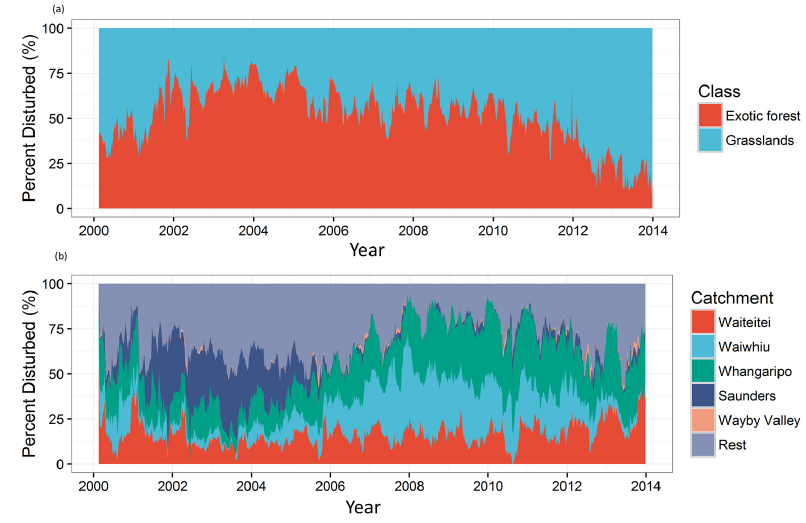
Figure 3. ( a ) Relative contributions of exotic forest (orange) and pasture (blue) to overall watershed disturbance; ( b ) Disturbance contribution (%) of each sub-catchment relative to the total watershed disturbance.